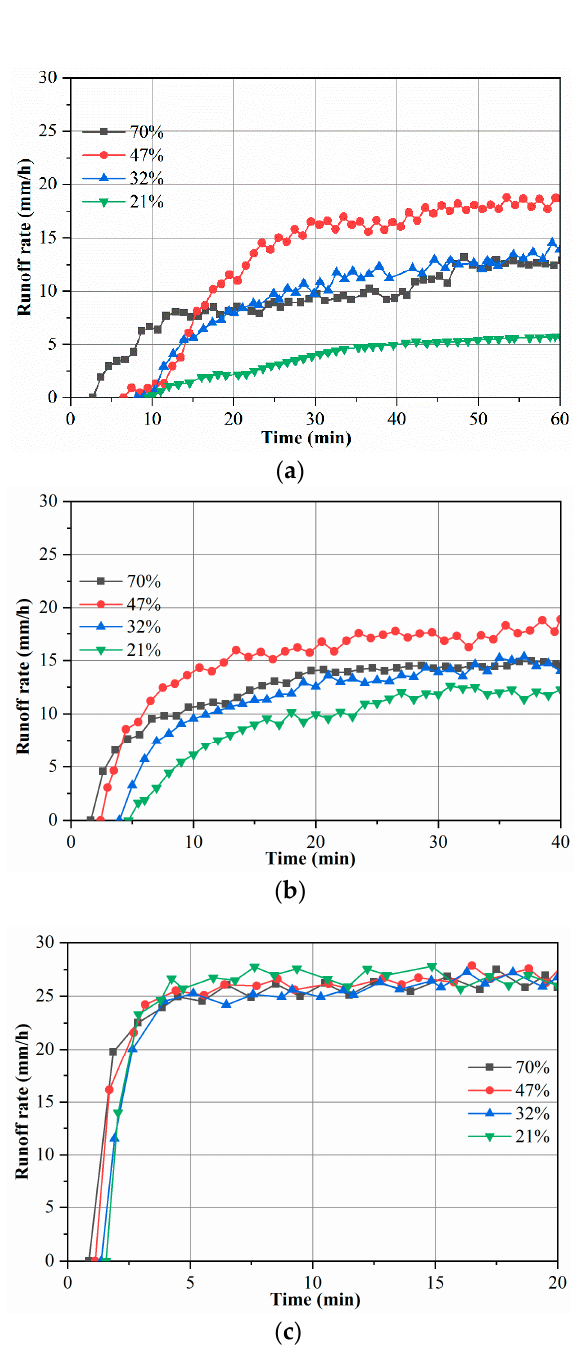
Figure 7. Runoff rate as a function of time on each slope under different rainfall events: ( a ) Dry run; Figure 7. Runo ff rate as a function of time on each slope under di ff erent rainfall events: ( a ) Dry run; ( b ) Moderate run; ( c ) Wet run. ( b ) Moderate run; ( c ) Wet Table 3. Fitted equations of runoff rate with time.